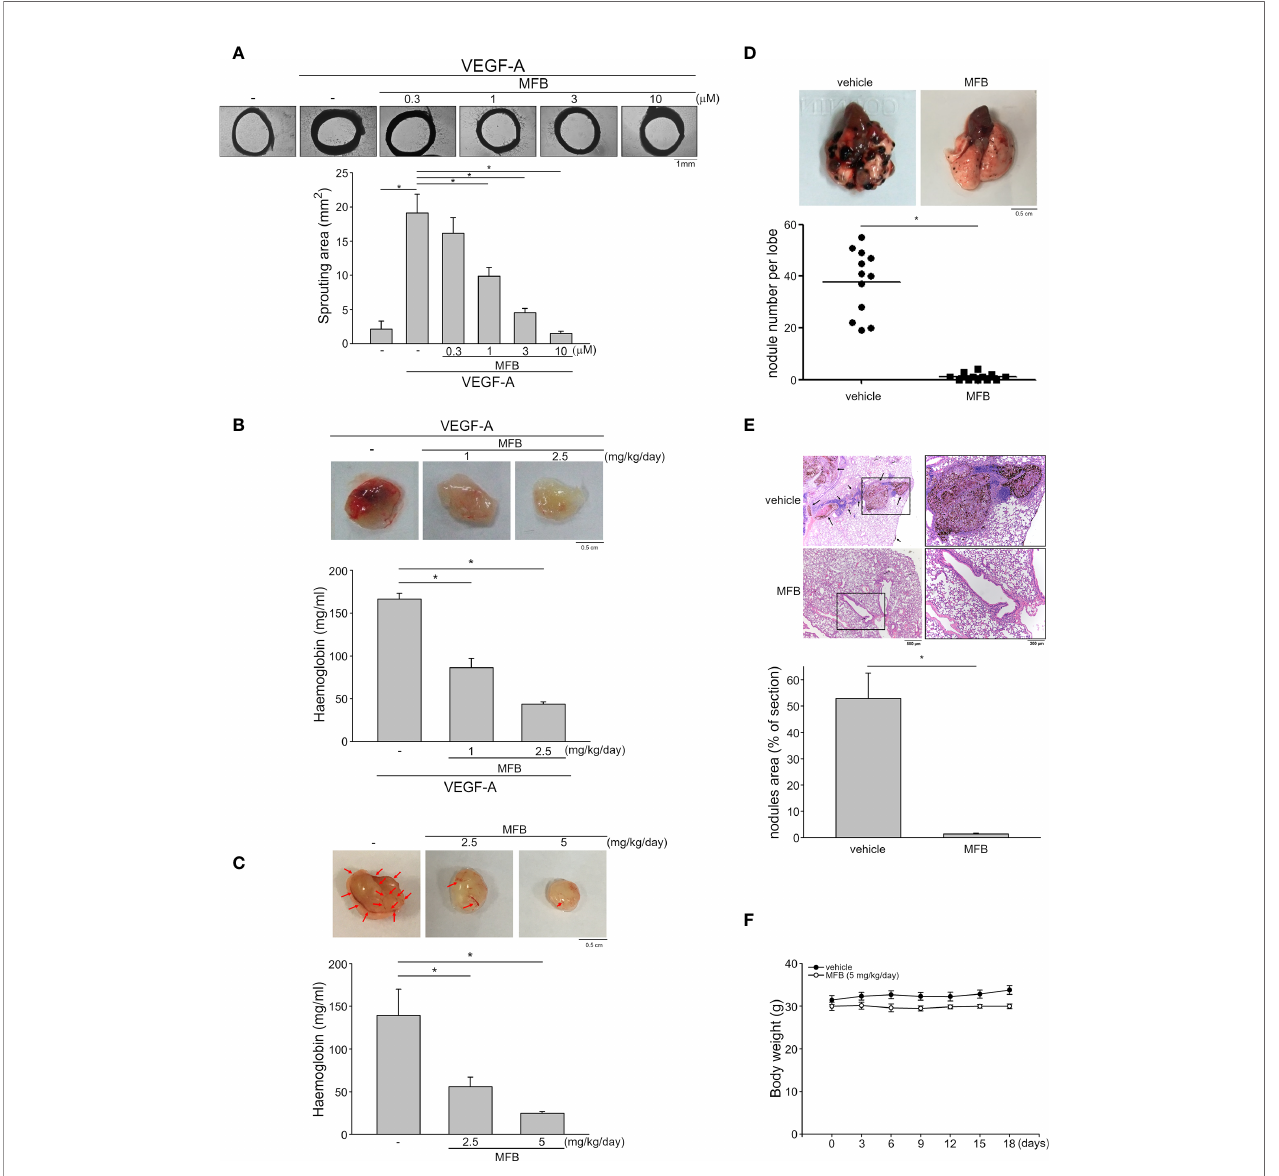
FIGURE 3 | MFB reduced VEGF-A- or tumor cells-induced angiogenesis in vivo and suppressed murine melanoma B16F10 cell lung metastasis. ( A ) Rat aortic rings were placed in Matrigel with VEGF-A (25 ng/ml) in the presence or absence of MFB. The formation of microvessels sprout from aorta ring samples was determined on day 8. Bar graphs show compiled data of the average microvessels area (n=6). *P <.05, signi fi cantly different from VEGF ‐ A alone; one ‐ way ANOVA, with Tukey ’ s post ‐ hoc test. (B) Matrigel mixed with VEGF-A (100 ng/ml) was subcutaneously injected into the right fl ank of nude mice. After implantation, mice were administrated intraperitoneally with vehicle or MFB for 7 days. Matrigel plugs removed from the mice treated with vehicle or MFB were shown in the upper of the chart. Hemoglobin levels in the matrigel plugs were quanti fi ed. Each column represents the mean ± S.E.M. of eight plugs in each group. *P <.05, signi fi cantly different from VEGF ‐ A-treated group; one ‐ way ANOVA, with Tukey ’ s post ‐ hoc test. (C) Matrigel mix with GBM8901 cells was subcutaneously injected into the right fl ank of nude mice. After implantation, mice were administrated intraperitoneally with vehicle or MFB for 10 days. Matrigel plugs removed from the mice treated with vehicle or MFB were shown in the upper of the chart. Hemoglobin levels in the matrigel plug were quanti fi ed. Arrows point to newly formed microvessels in the matrigel plug. Each column represents the mean ± S.E.M. of six plugs in each group *P <.05, signi fi cantly